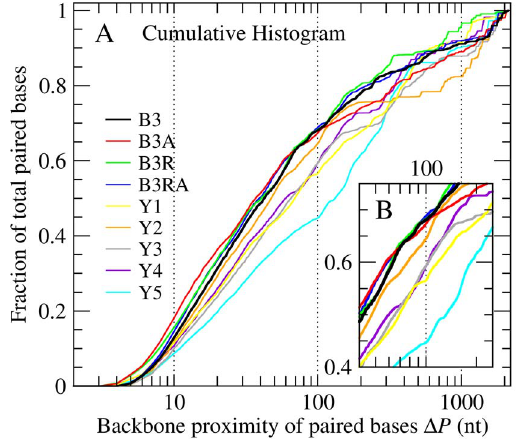
Figure 4. Base-pairing proximity for 2117-nt RNAs. Ensemble- averaged cumulative histograms of backbone distance between paired bases ( D P ) are in F & G. Viral and non-viral histograms diverge up to D P ~ 100 and converge thereafter. Unlike in yeast RNAs, over 70% of base pairs in B3 (See inset G) have D P v 100 . This predominance of proximal base pairing leads to compact secondary structures.